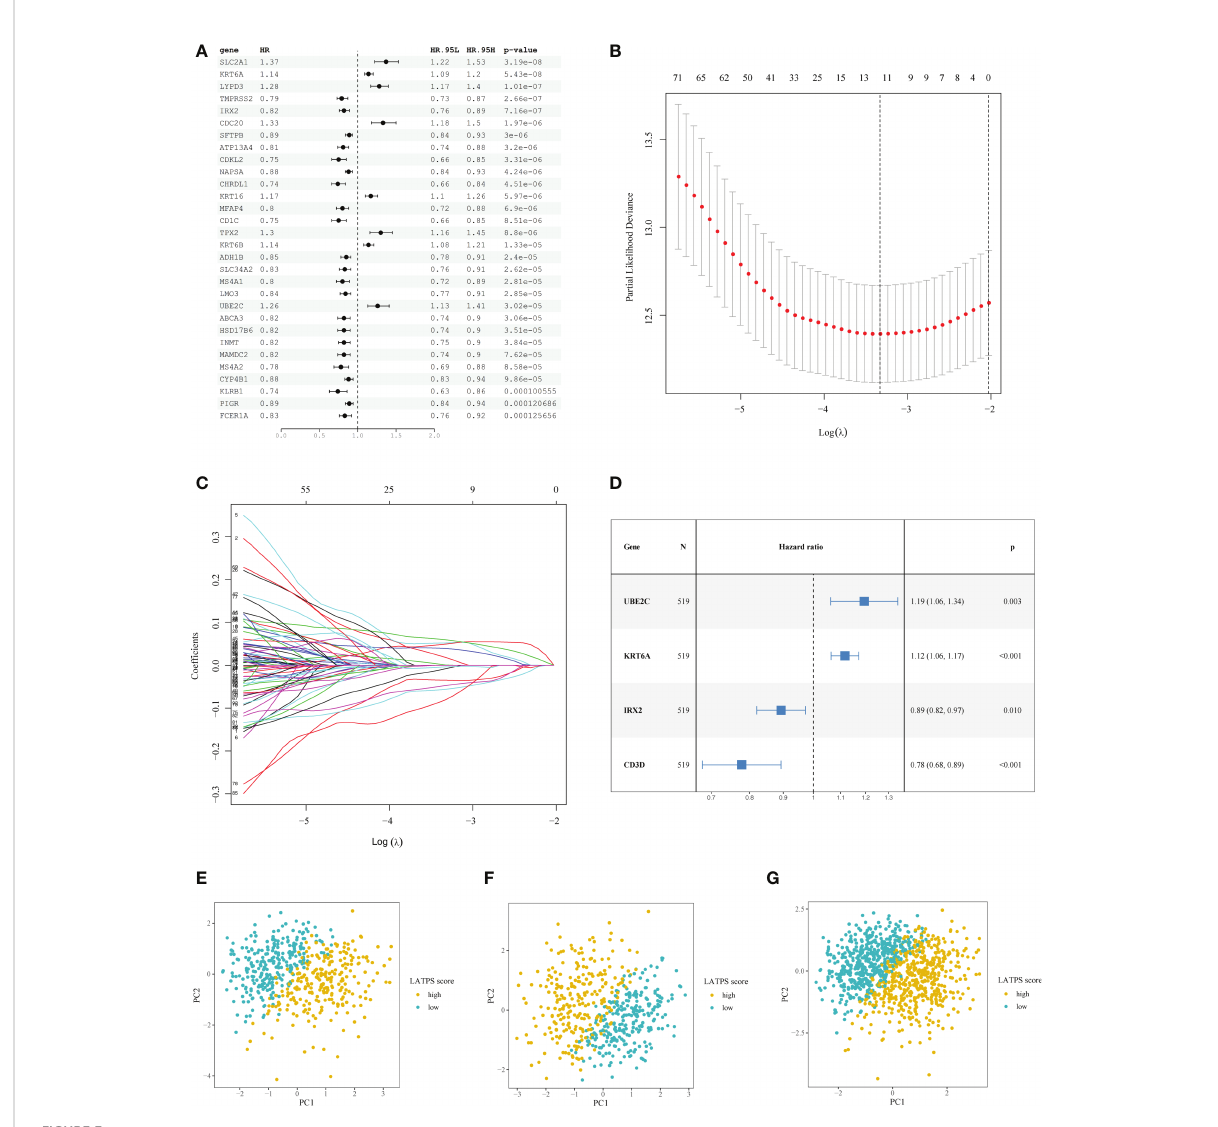
coef fi cient pro fi les of the 93 candidate prognostic genes. (D) Forest plot illustrating the multivariate Cox model results. PCA showing the distribution differences between the LATPS-high and LATPS-low subgroups of the (E) training, (F) test, and (G) total cohorts. LATPS, LUAD tumor microenvironment prognostic signature; LASSO, least absolute shrinkage and selection operator; PCA, principal component